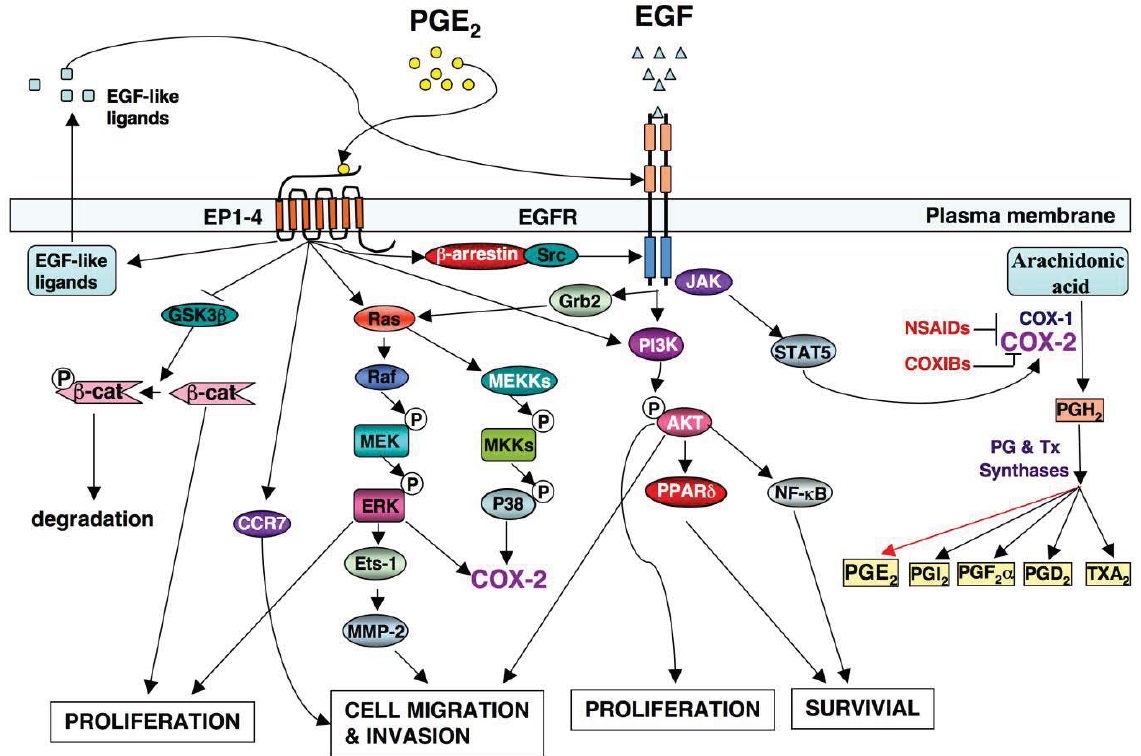
Figure 1. The crosstalk between COX-2 and EGF signaling pathway in